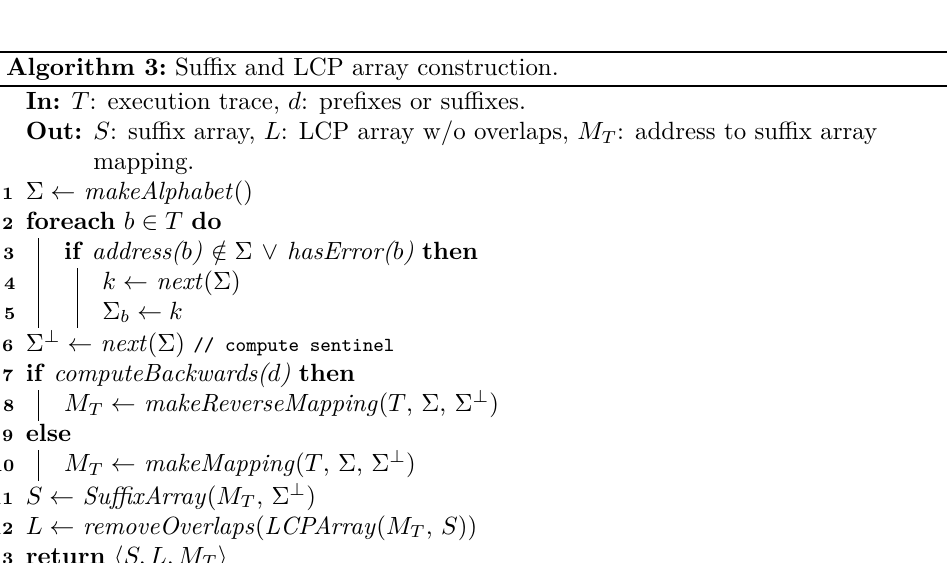
Algorithm 3: Suffix and LCP array